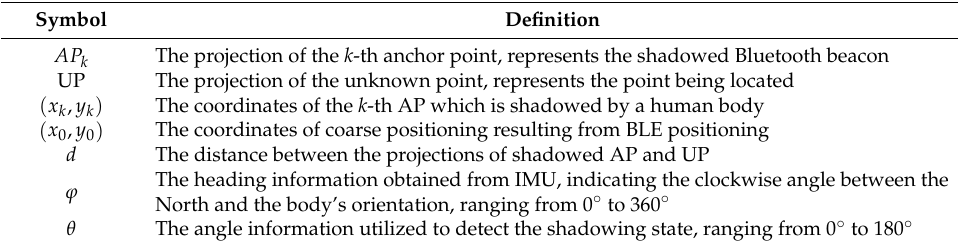
Table 1. Symbol definitions in the diagram of the body-shadowing detection